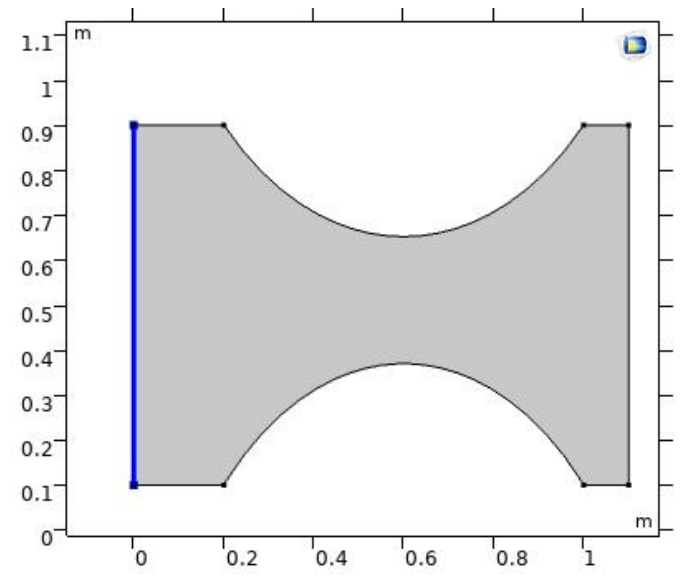
Figure 2. The geometry of the inlet.